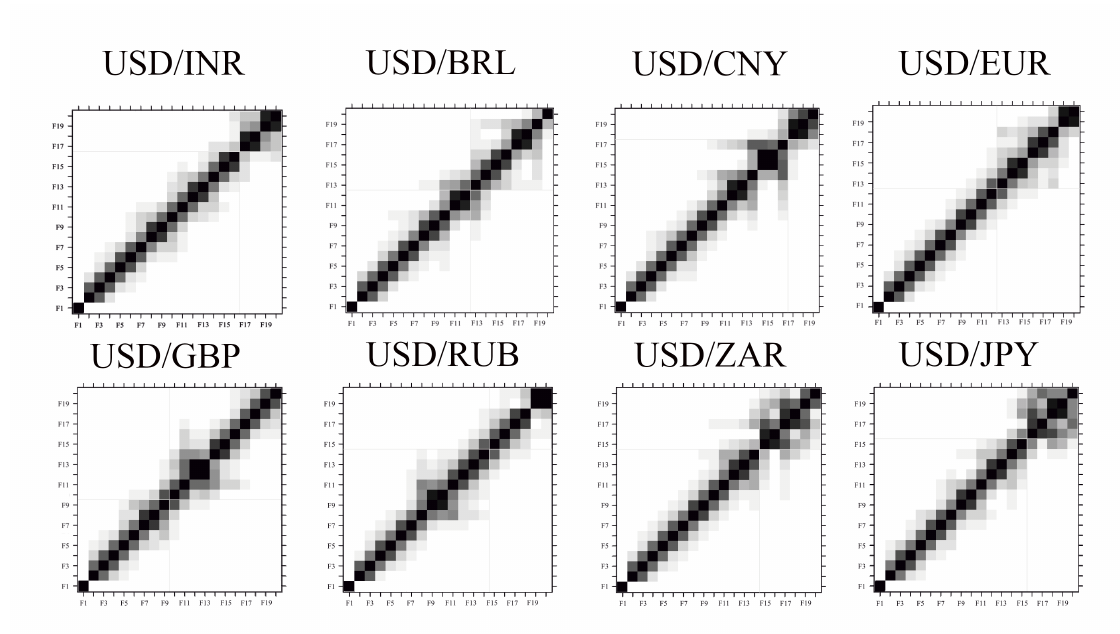
Figure 3. W-correlation matrices for each of the eight currency exchange rates, considering an window length L p . The vertical and horizontal lines in each w-correlations plot indicate the selected cut-point that maximize separability between signal and noise components.